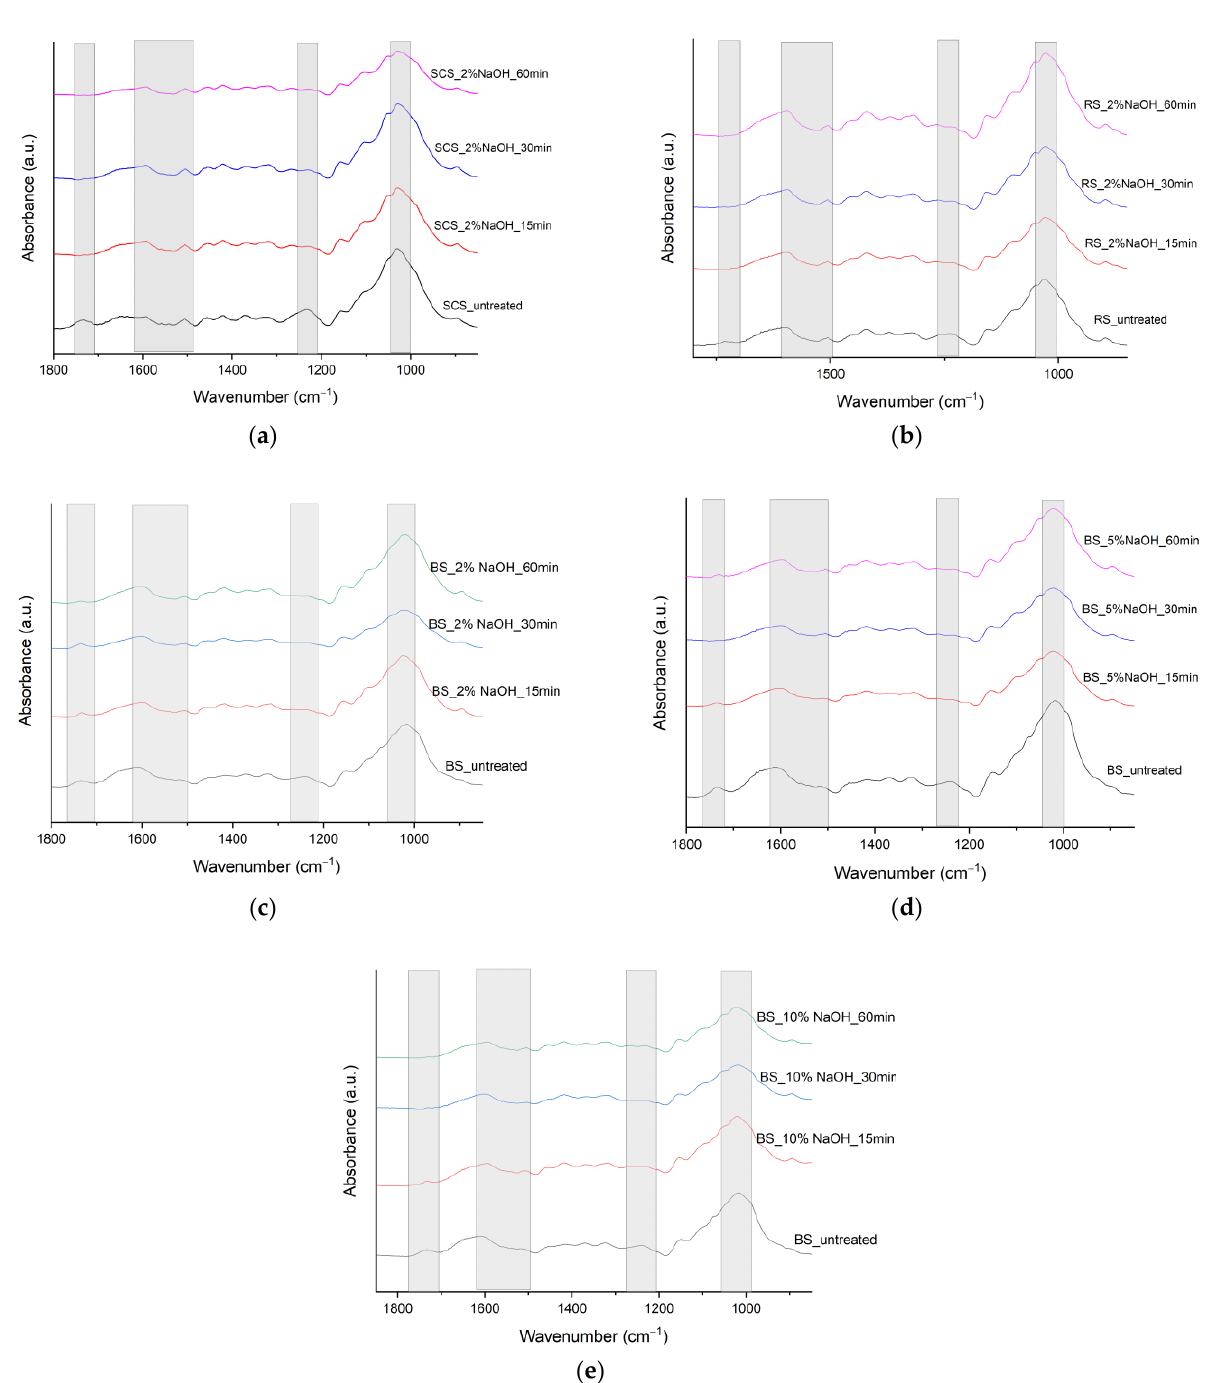
Figure 2. FTIR spectra of untreated and treated ( a ) SCS, ( b ) RS, and ( c – e ) BS fibers. According to the spectra, the peak for the hydroxyl (–OH) groups at ∼ 3300 cm − 1 wavenumber was the highest in fibers treated for 30 min. This was expected due to some of the lignin being removed. After lignin had been removed, the exposure of hydroxyl groups in hemicellulose and cellulose increased. The intensity of the hydroxyl groups eventually decreased with longer alkali treatment times. Results show that the hydroxyl stretching vibration continued to decrease as the treatment time increased to 16 h, which was expected due to the increased degradation of hemicellulose. After 16 h of treatment, very few changes were observed for the –OH peak. Since cellulose is fairly resistant to